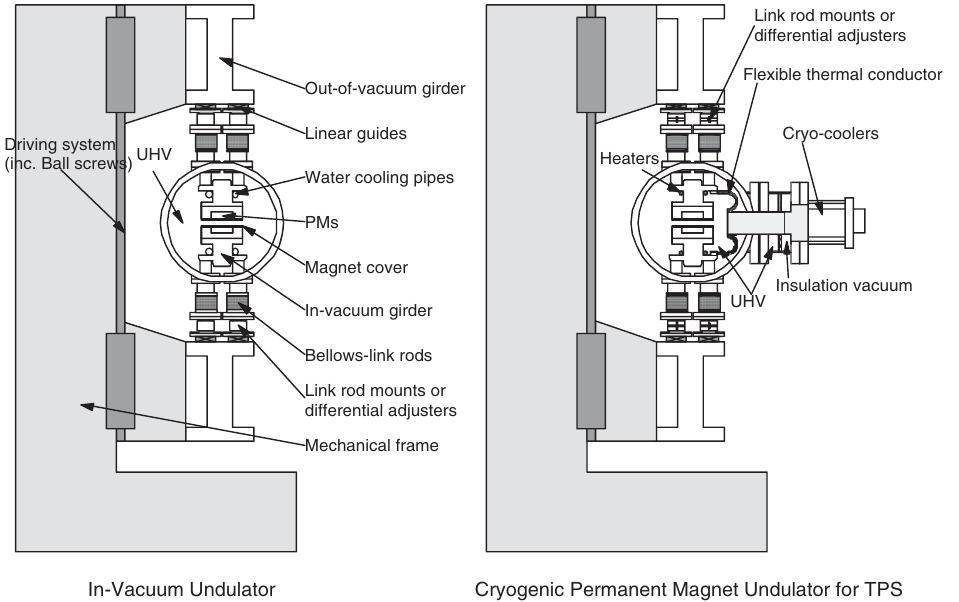
FIG. 1. Sketch of an in-vacuum undulator and cryogenic permanent magnet undulator for TPS.